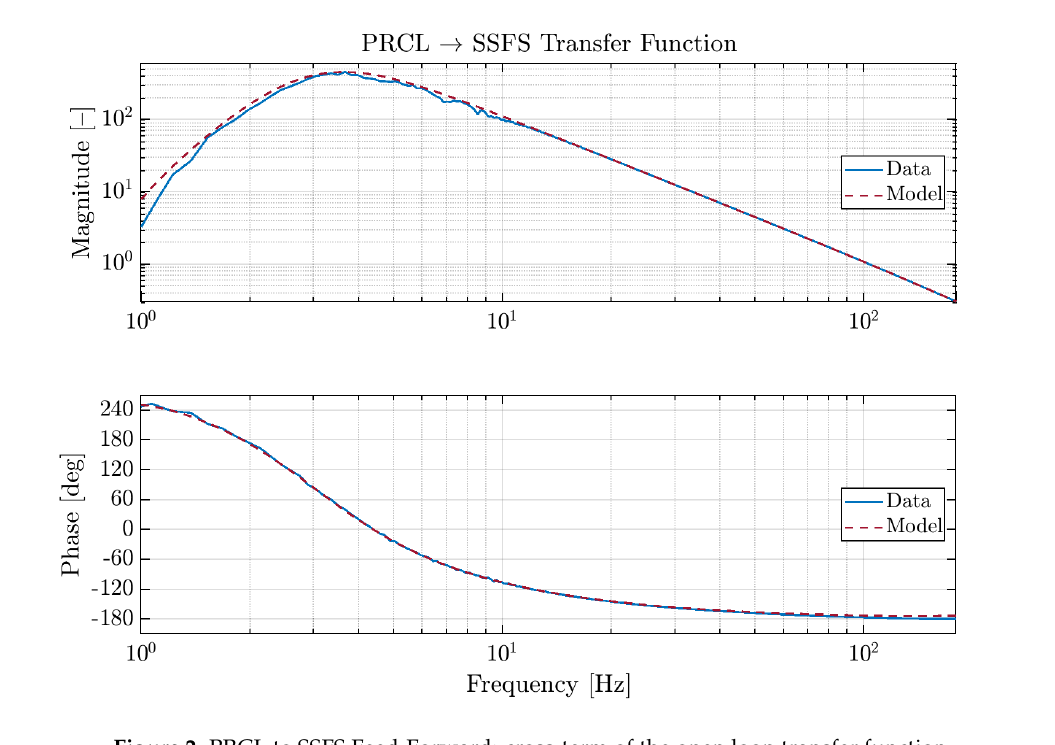
Figure 2. PRCL to SSFS Feed-Forward: cross-term of the open loop transfer